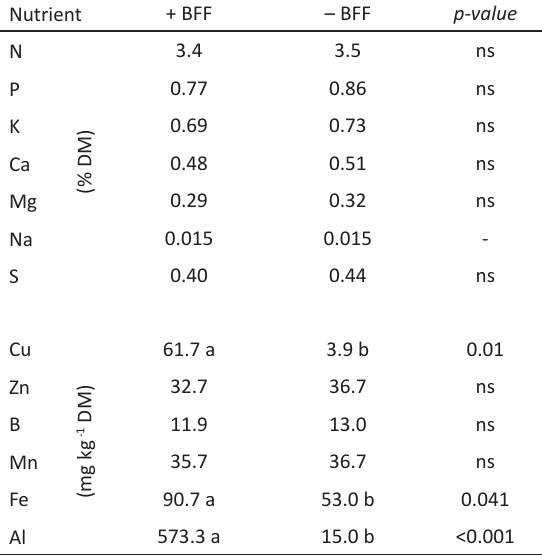
Table 2. Concentration of mineral nutrients in seeds with (+) and without (–) treatment with binder (B), filler (F) and Rovral